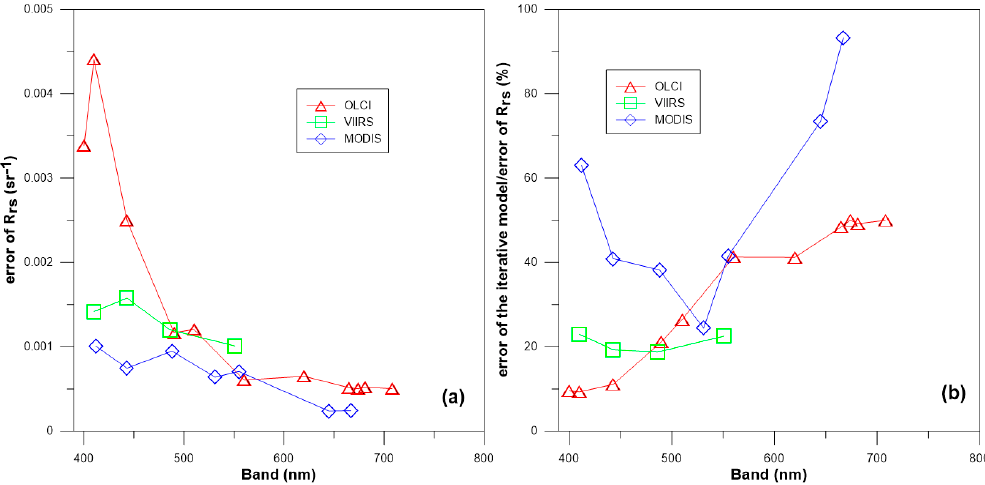
Figure 11. Mean error of R rs from OLCI, MODIS, and VIIRS in coastal water ( a ) and the mean percentage of the error of the iterative model in the error of R rs from OLCI, MODIS, and VIIRS in coastal water ( b